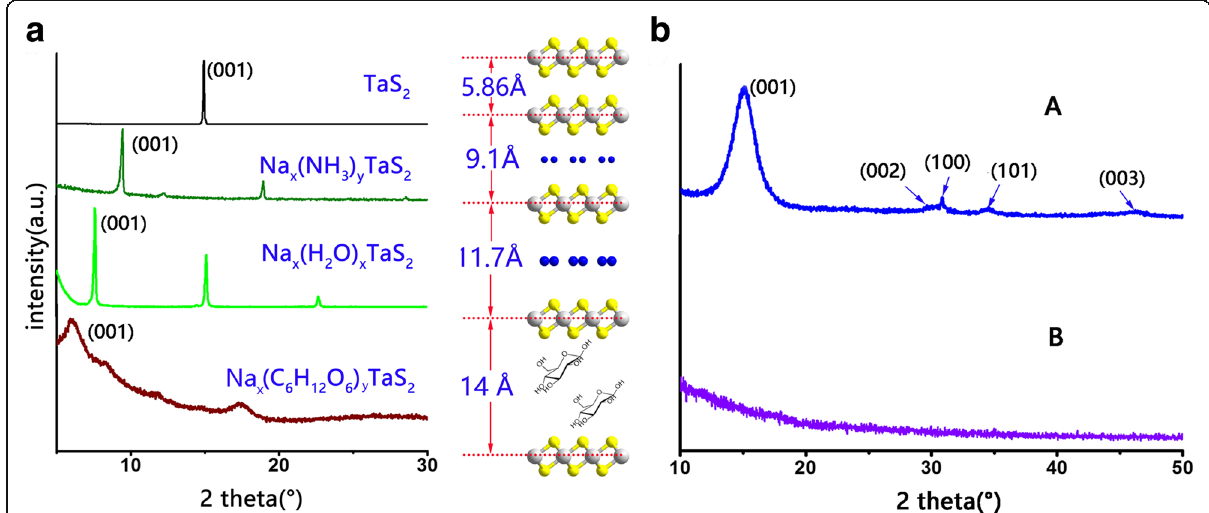
Fig. 2 a XRD pattern and schematic of pristine TaS 2 , Na(NH 3 )-intercalated TaS 2 , Na(H 2 O)-intercalated TaS 2 , and C 6 H 12 O 6 -intercalated TaS 2 . b XRD pattern of few-layer TaS 2 (A) and monolayer TaS 2